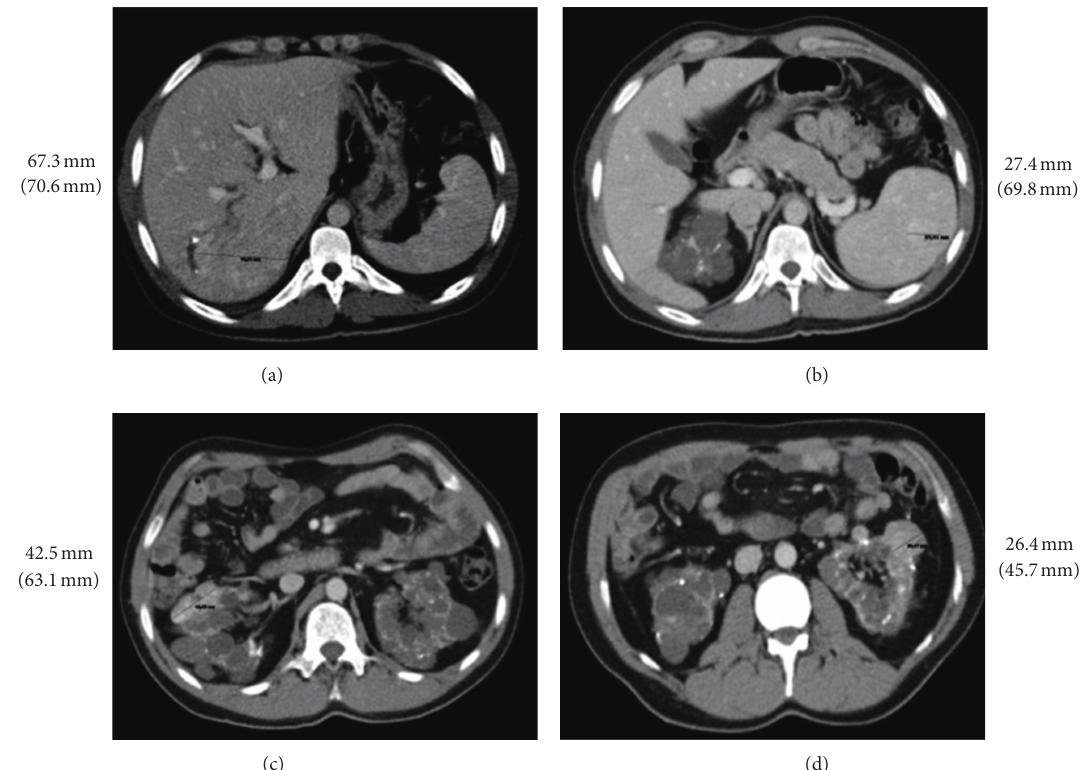
F 2: Abdominal CT performed aer two years of treatment with rapamycin, showing a signi�cant reduction in the size of tumours.